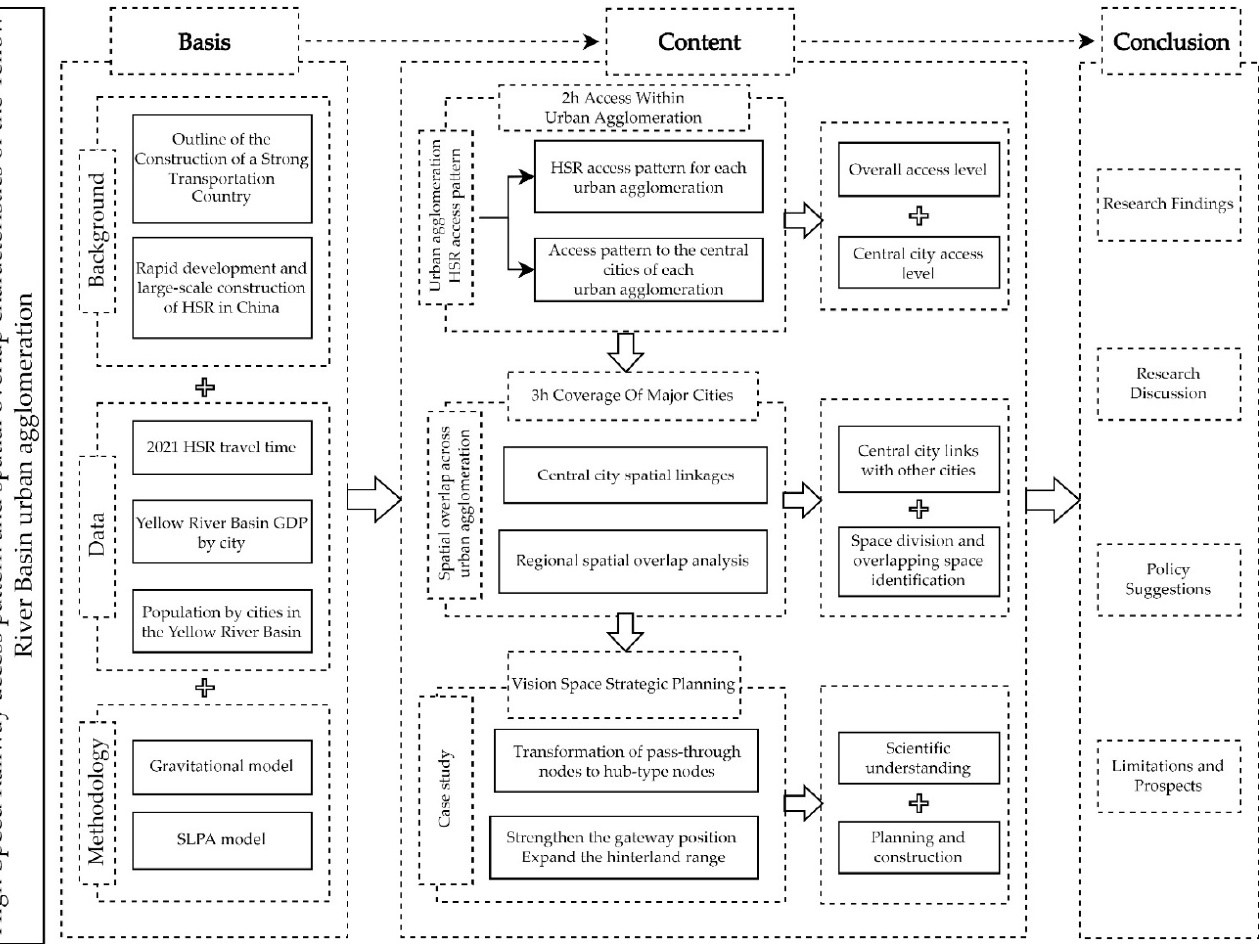
Figure 1. Research logic diagram.